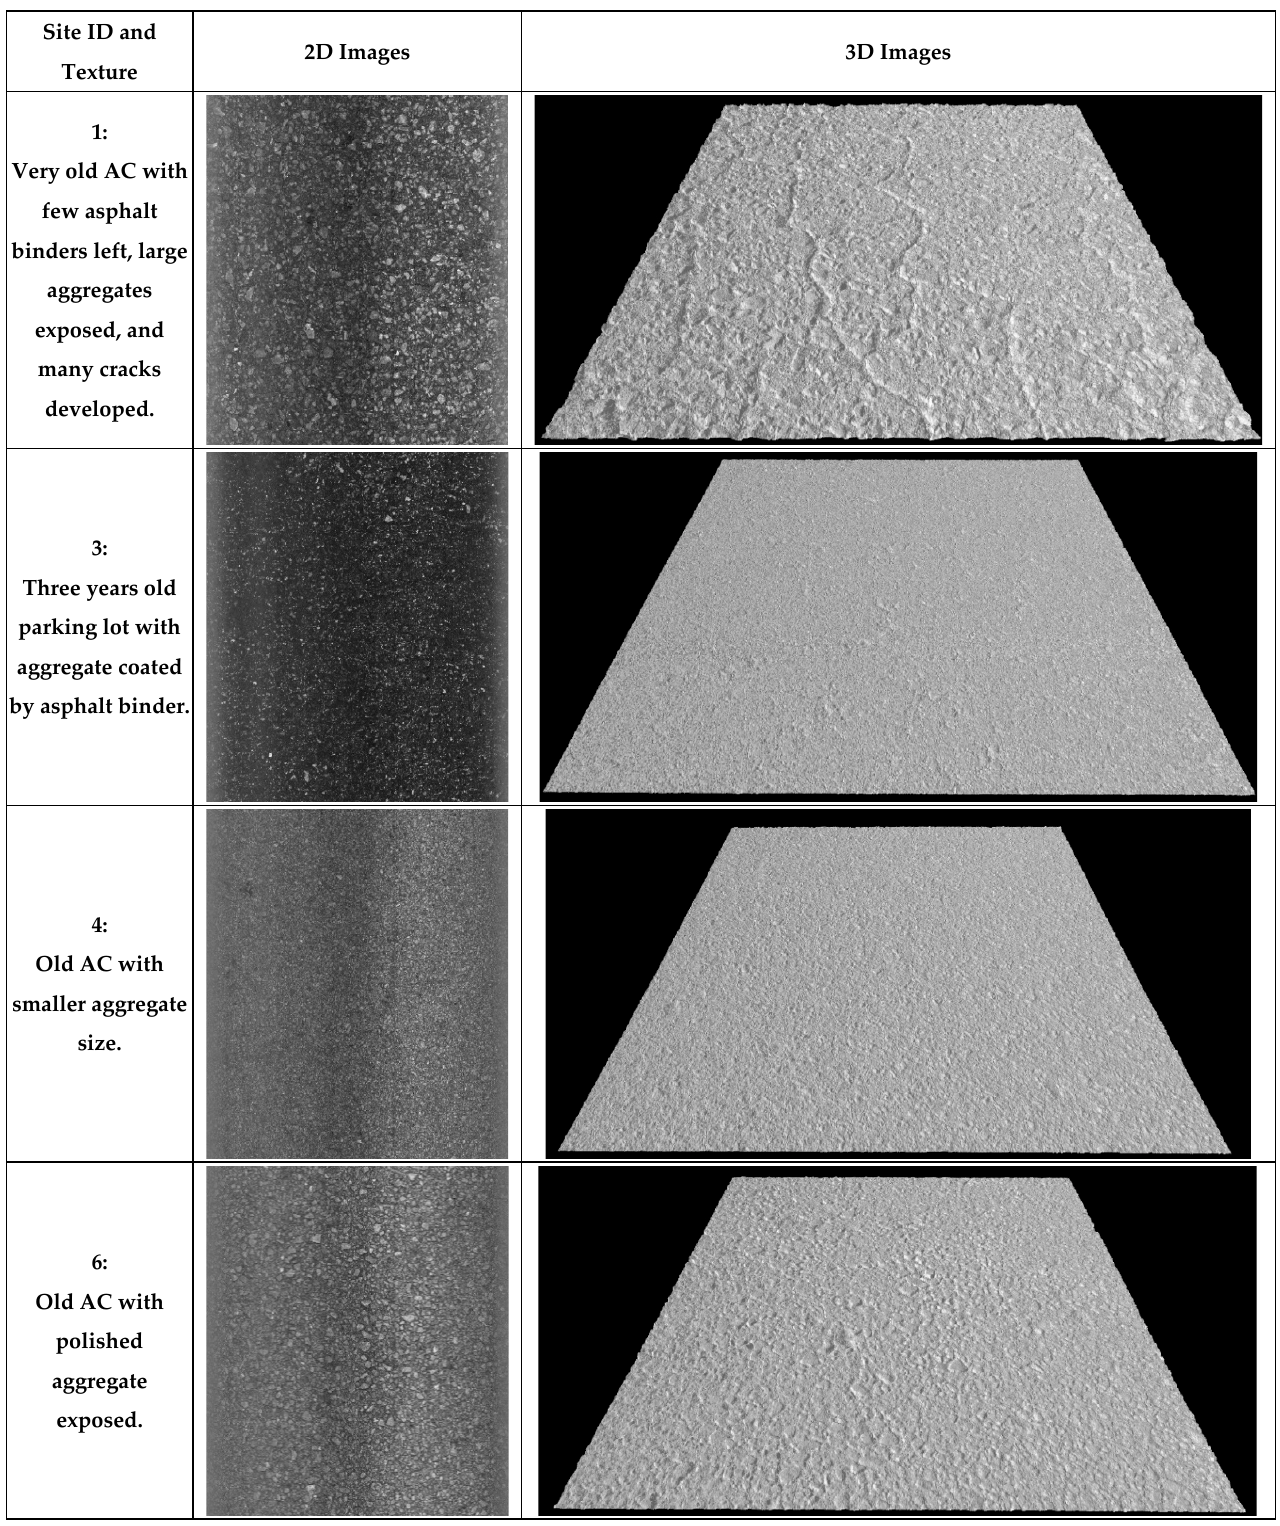
Figure 2. Data collection devices: ( a ) LS-40, ( b ) DFT, ( c ) High-speed texture profiler, and ( d ) Safety Sensor.